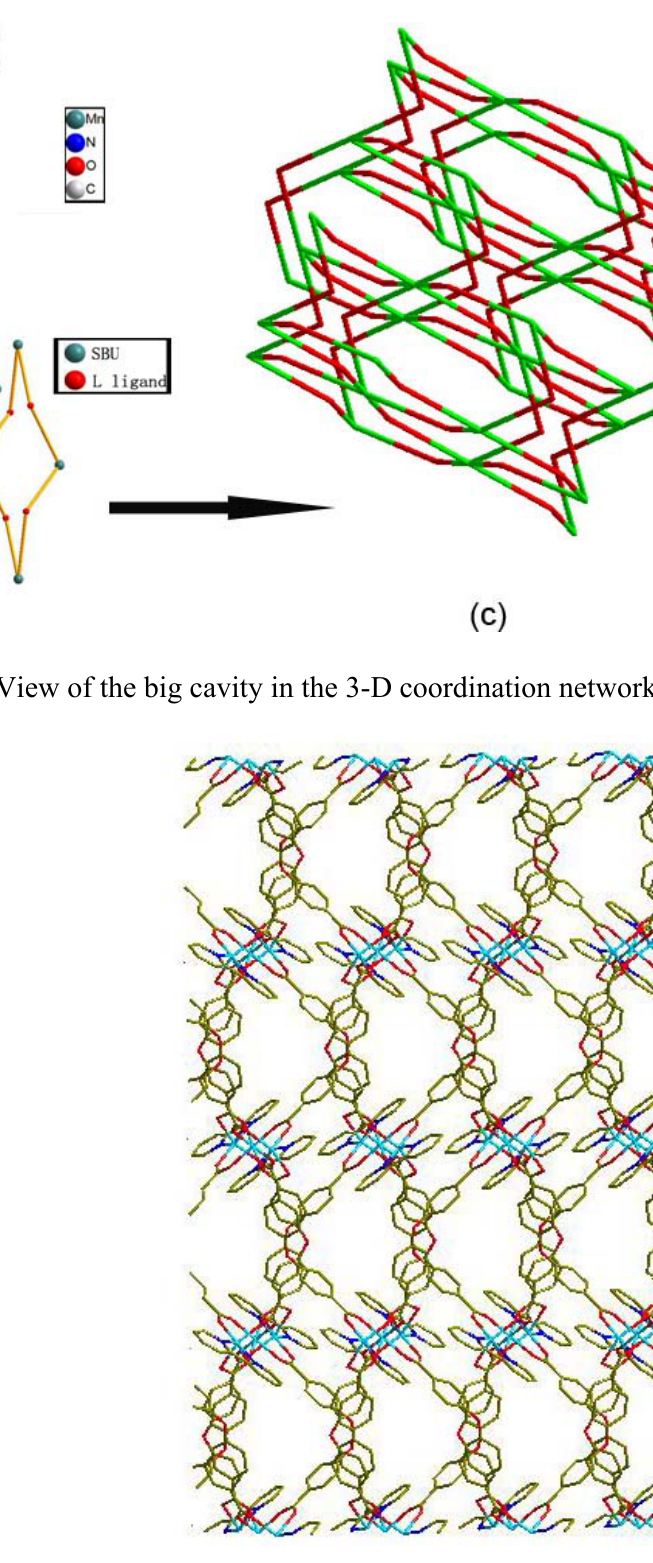
Figure 3. ( a ) Thermal ellipsoid-and-stick representation of SBU; ( b ) Each SBU as a 6-connected node bridged by L ligands to connected with other six SBU nodes; ( c ) A schematic view of the (2,6)-connected (8 12 ·12 3 )(8)(3) topology of a 3-D coordination network in 1 (green: SBU; red: L ligand).